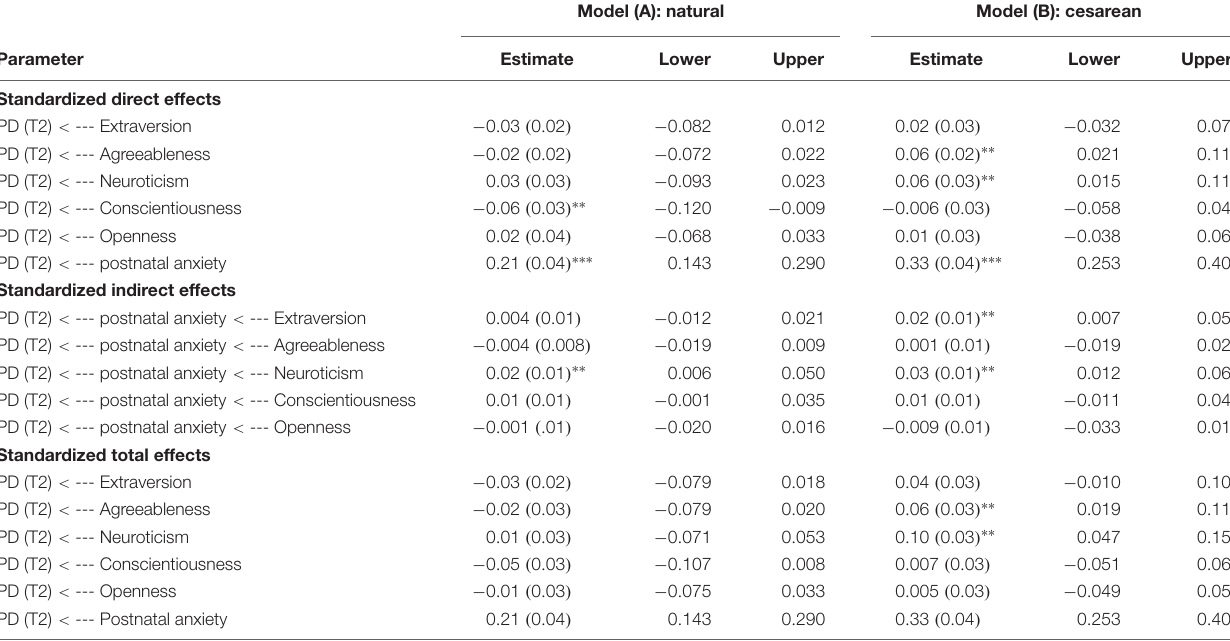
TABLE 4 | Direct and indirect effects and 90% confidence